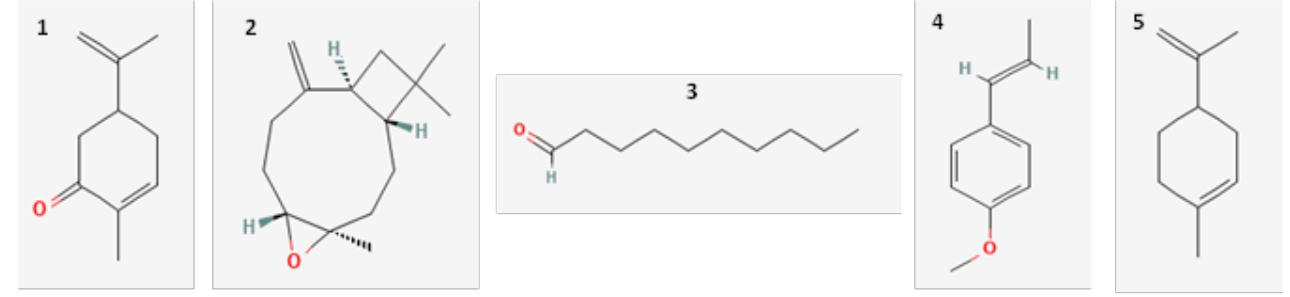
Figure 4. Chemical structure of the main five constituents identified in Okra extract. ( 1 ) carvone; ( 2 ) β -caryophyllene; ( 3 ) decanal; ( 4 ) (E)-anethole; and ( 5 ) limonene. Table 4. GC – MS identification of phytoconstituents in Okra extract.